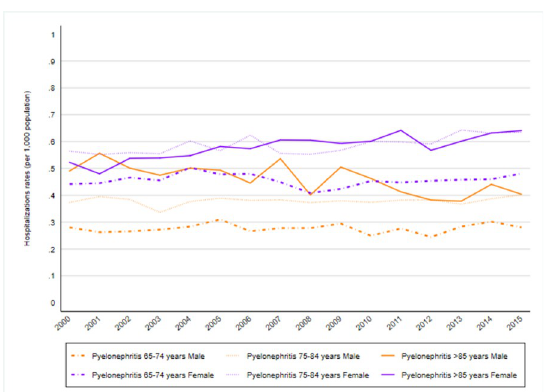
Fig 5. Pyelonephritis. Pyelonephritis hospitalization rates by sex and group of age (2000–2015).